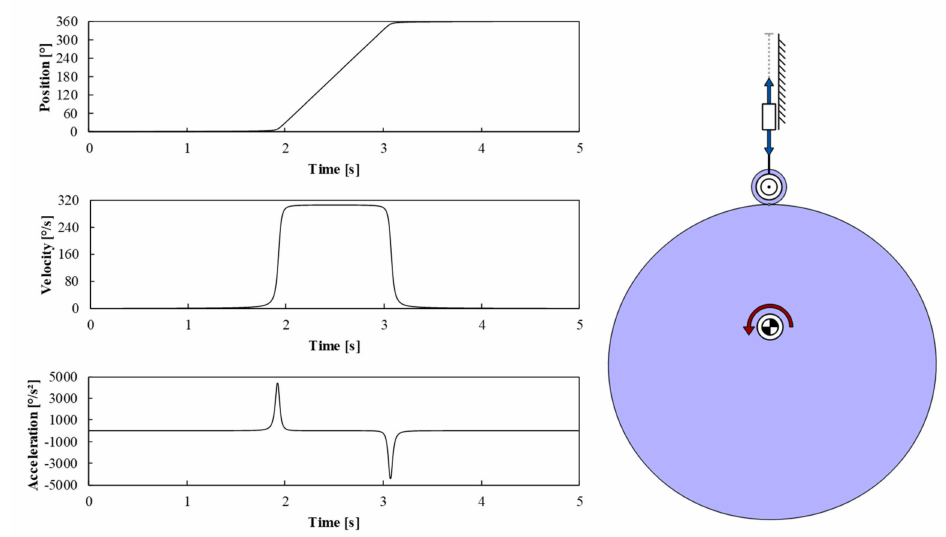
Figure 6. Servo drive: input motion of the cam (left) and resulting mechanism (right).